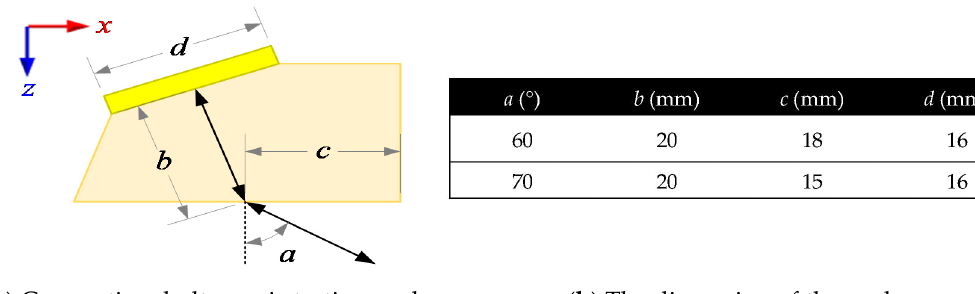
Figure 7. Configuring the CIVA model and input parameters.